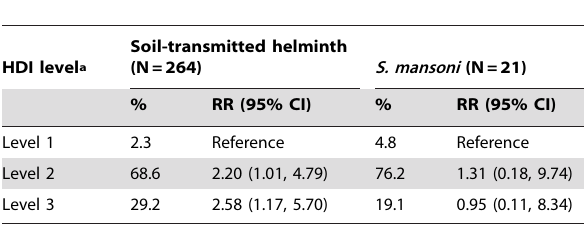
Table 2. Risk of helminth infection by household development index